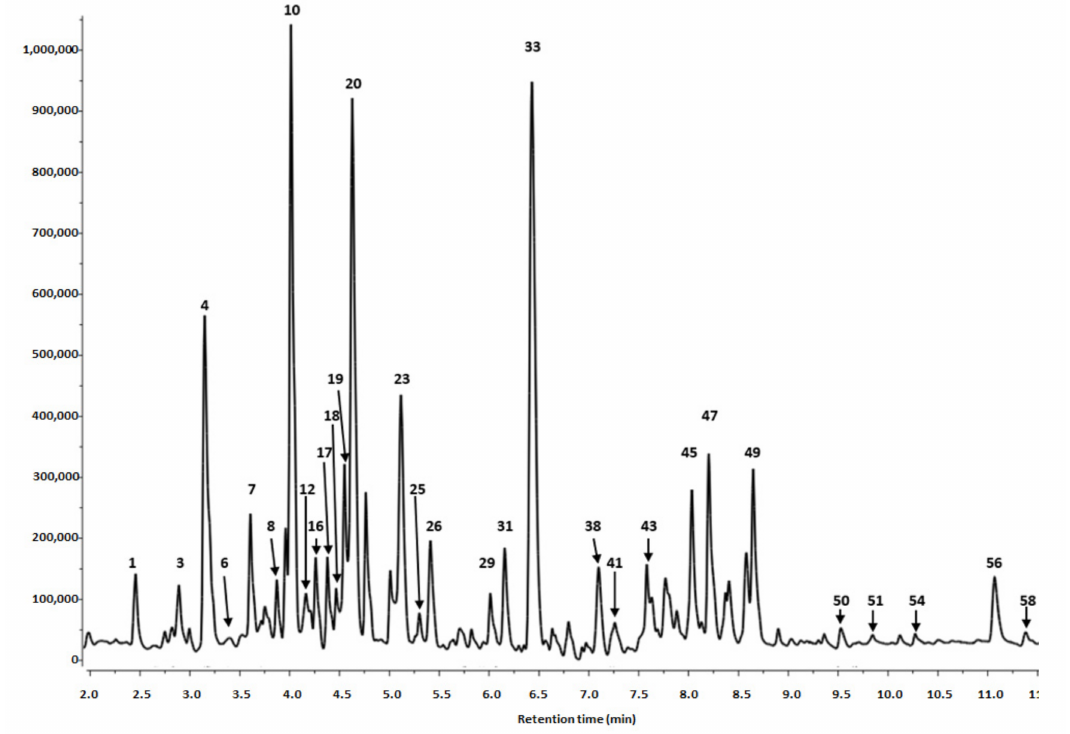
Figure 2. Segment from 2.00 to 11.50 min of LC-DAD chromatogram at 280 nm of S. alba bark. Peak number identities are displayed in Table